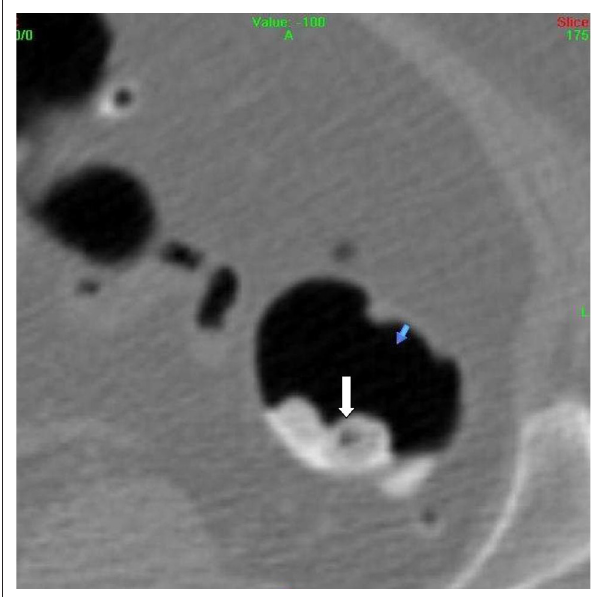
FIGURE 8: Air in stool (arrows).